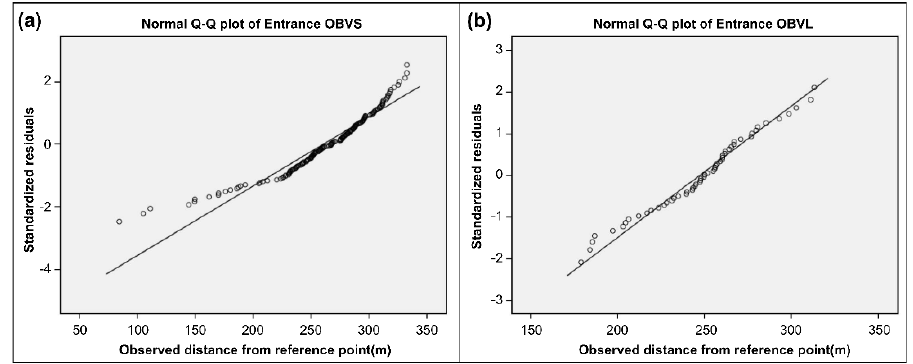
Figure 9. Normal Q–Q plot of OBV of the entrance part: ( a ) small vessels and ( b ) large